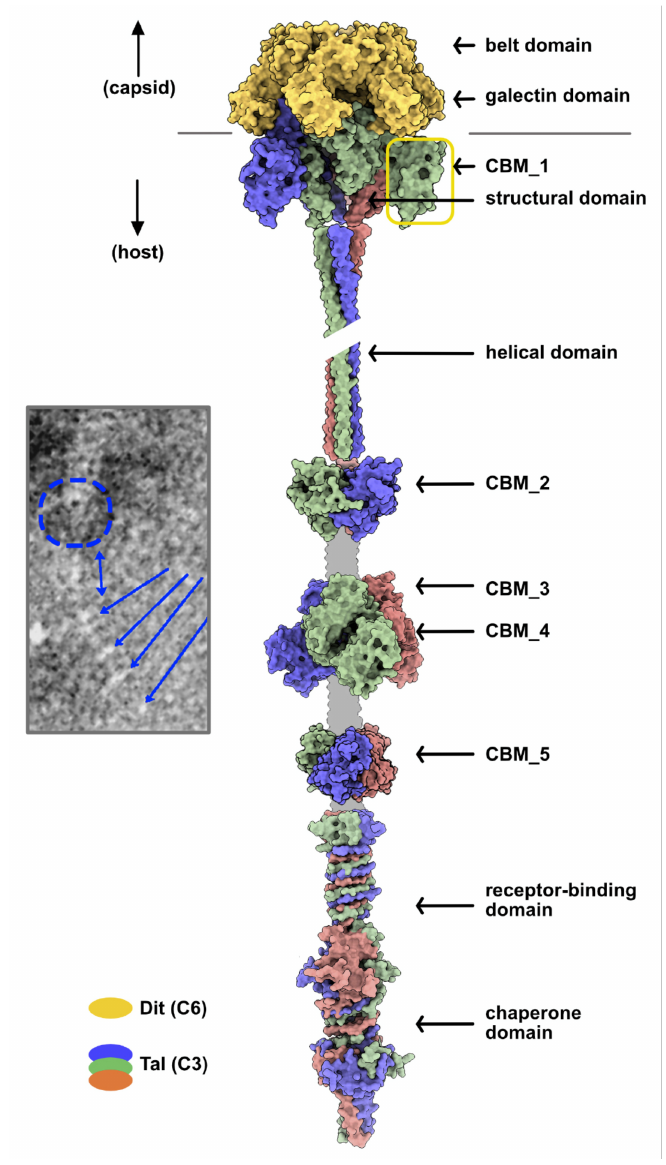
Figure 5. Topological model of the Vinitor162 adhesion device. This model was generated from the Dit hexamer and Tal trimer in the crystal structure of the phage p2 baseplate in its resting state. The trimerized CBMs were added to the sequence along the elongated structure. The color code is indicated, and the unpredicted linkers are shown in grey. Inset: nsEM image of Vinitor162 tail tip [4]. The putative location of the Tal structural domain is indicated by a dotted blue circle, the elongated helical domain is indicated by a blue double arrow, and CBM_2-5 and the C-terminal domain are indicated by blue